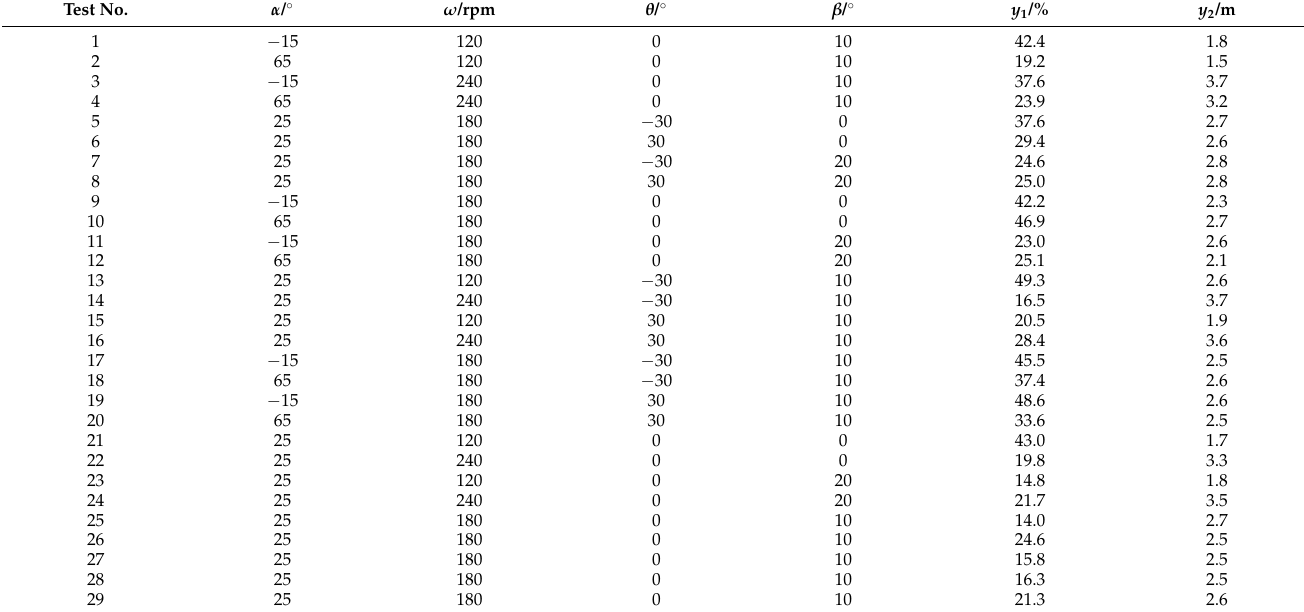
Table 4. Cross-factor simulation